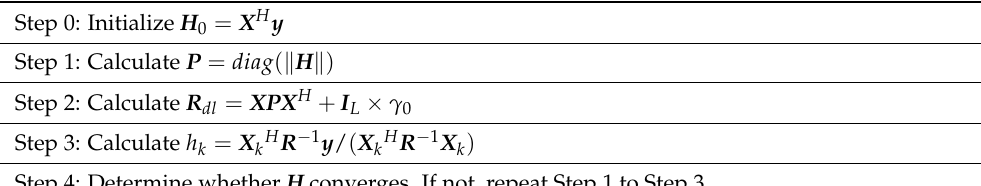
Table 1. The flow chart of diagonal loading IAA